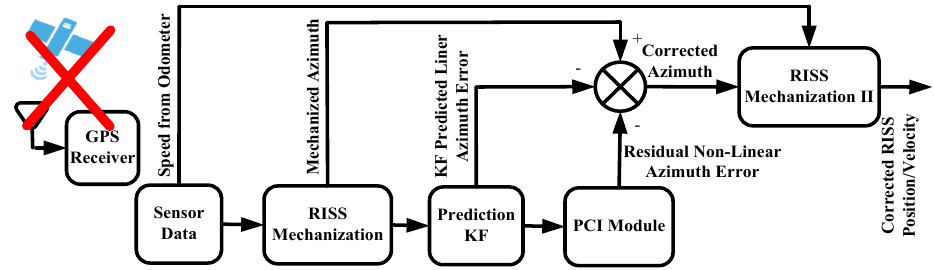
Figure 10. Loosely coupled KF-PCI technique during the GNSS outage. A road test trajectory using ultra-low-cost ADI IMU and the low-cost Trimble Lassen SQ GNSS receiver was conducted in Kingston, ON, Canada, for nearly 2000 s. The NovAtel ProPak-G2-Plus combines a GNSS receiver, and the Honeywell HG1700 IMU via SPAN technology is used as a reference navigation solution. The specifications of the utilized IMUs can be found in Table